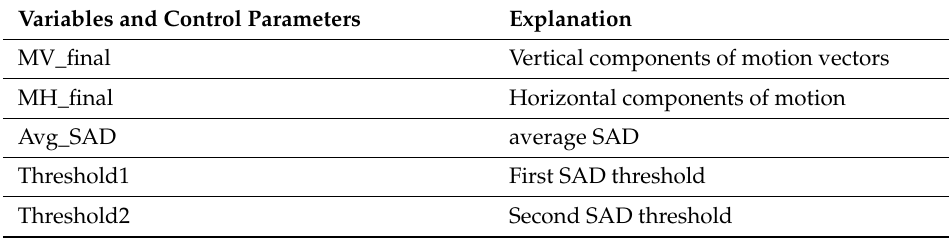
Table A2. Variables and control parameters list.